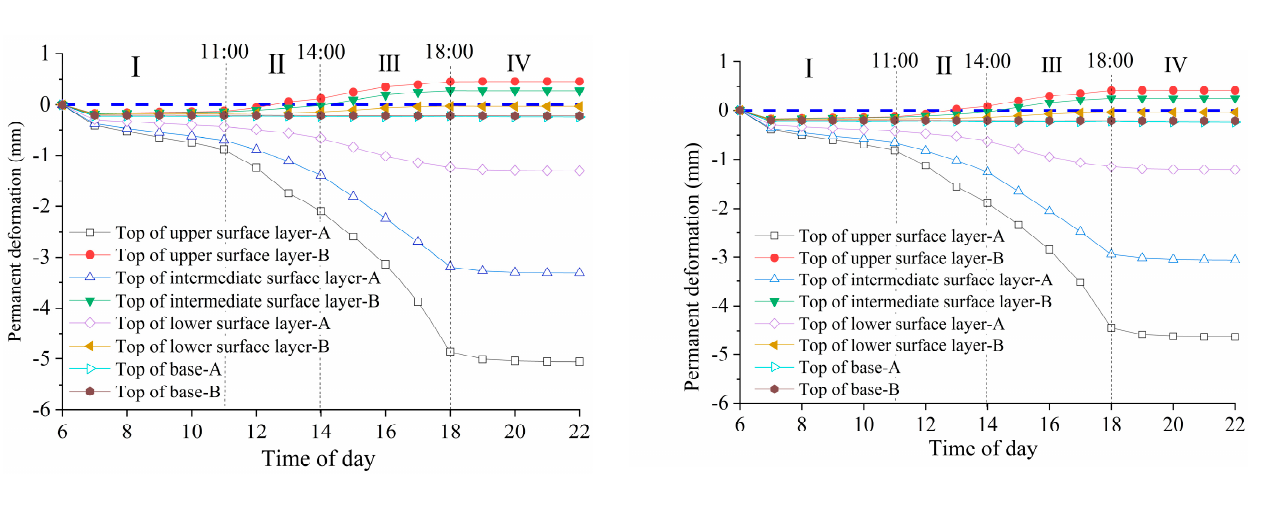
Figure 18. Variation in permanent deformation of asphalt pavement over time at vehicle speeds of ( a ) 10 km/h, ( b ) 20 km/h, ( c ) 30 km/h, and ( d ) 40 km/h. ( a ) 10 km/h, ( b ) 20 km/h, ( c ) 30 km/h, and ( d ) 40